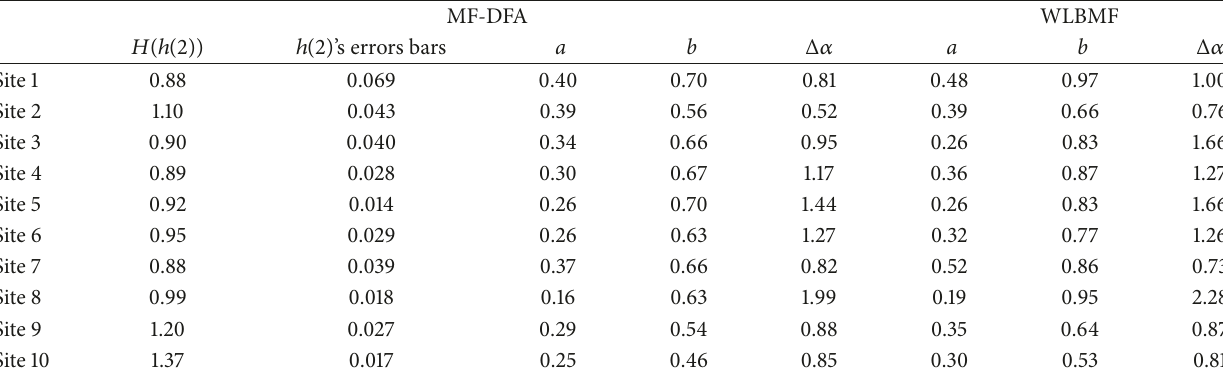
Table 8: The results of MF-DFA and WLMF for 10